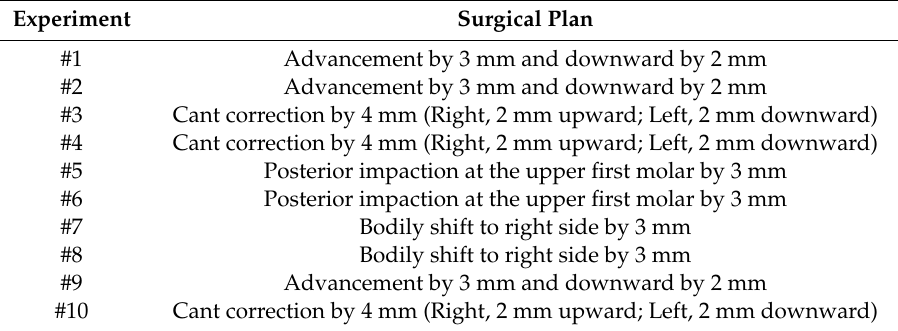
Table 1. The surgical plans implemented in this study.